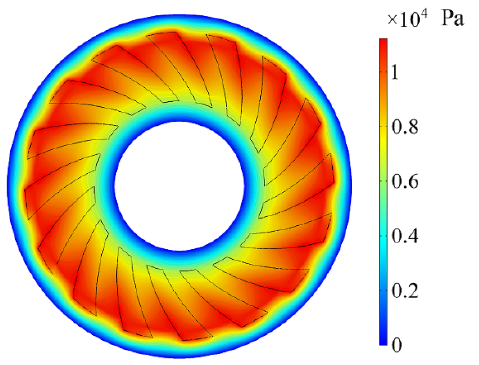
Figure 11. Pressure distribution of the hydrodynamic bearing surface.